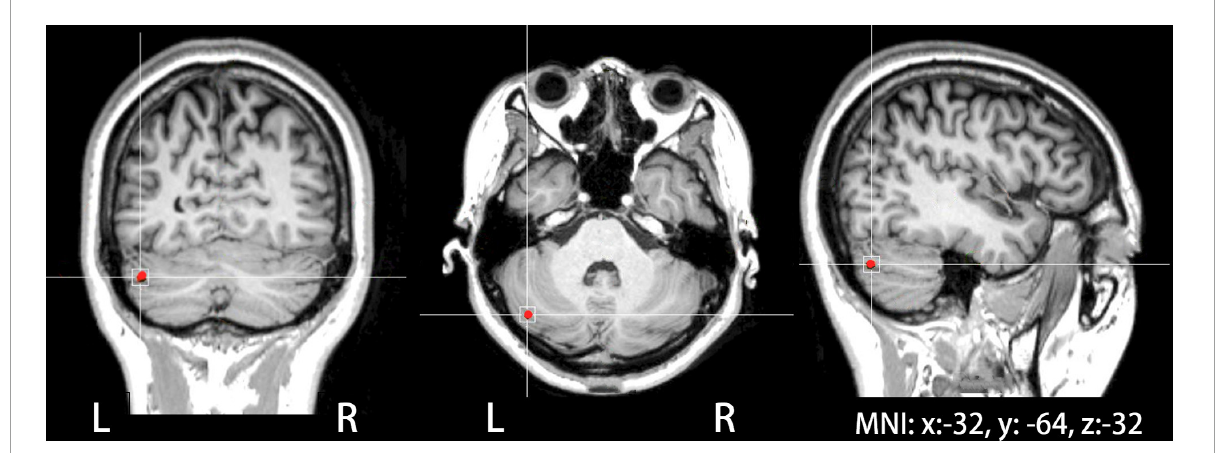
FIGURE1 The site of theta burst stimulation (TBS) stimulation located in the left cerebellar lobule VII (Crus I), which was identified on individual MRIs in coronal, axial, and sagittal views of the brain with the help of a neuronavigation system.